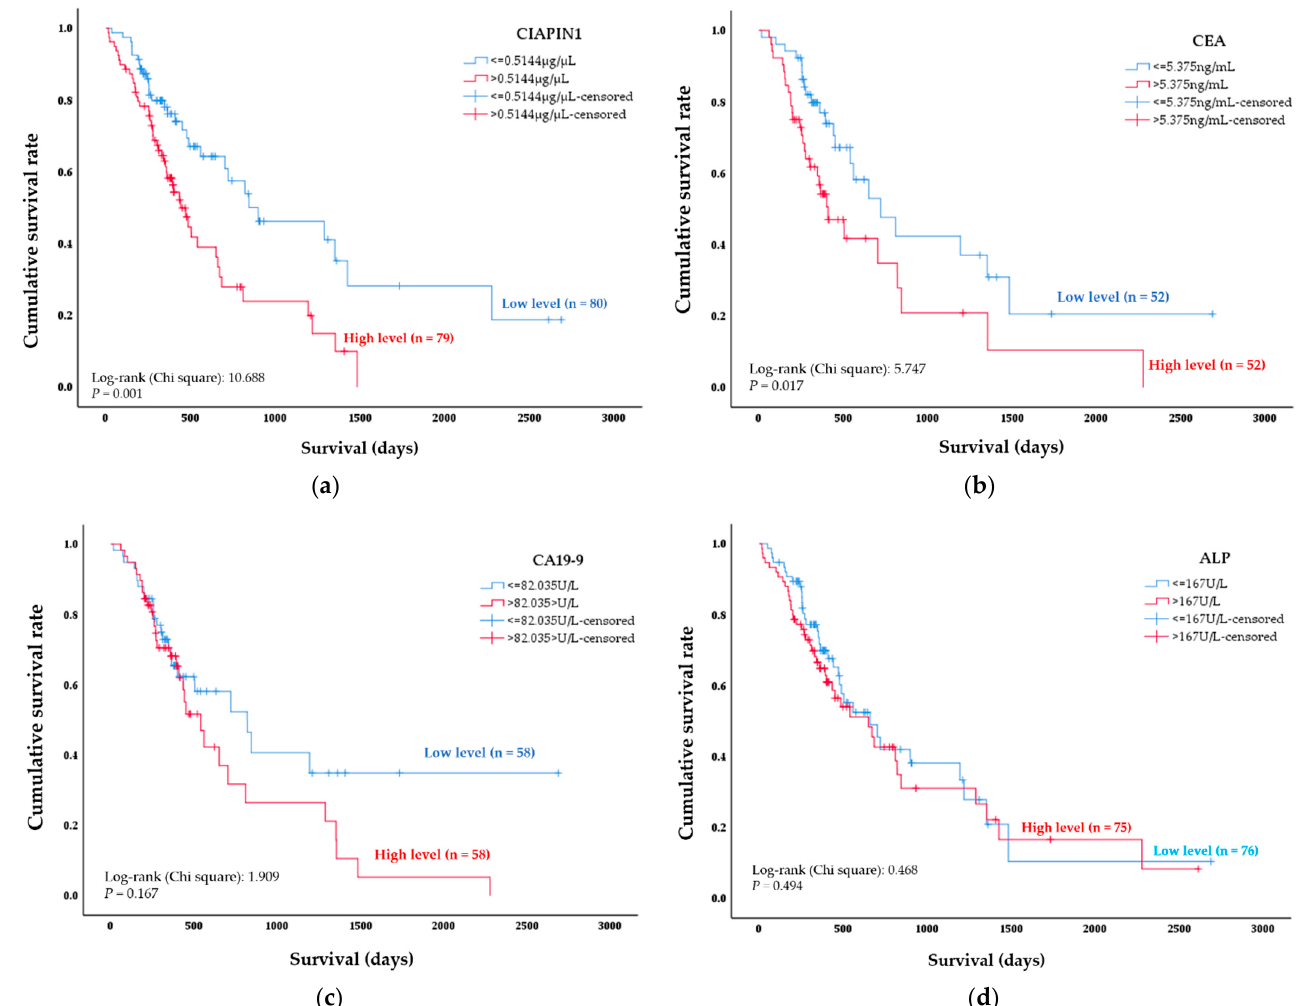
Figure 5. Kaplan–Meier plots showing the comparison of overall survival time of CCA patients according to the serum levels of ( a ) CIAPIN1, ( b ) CEA, ( c ) CA19-9, and ( d ) ALP. The curves show the overall survival of CCA patients having high (red line) and low (blue line) serum levels. A significant difference in the survival time was observed between high- and low-serum biomarker level groups by log-rank test and p < 0.05. Table 3. Univariate and multivariate Cox regression analyses of clinicopathological parameters and serum CIAPIN1 levels of CCA patients.